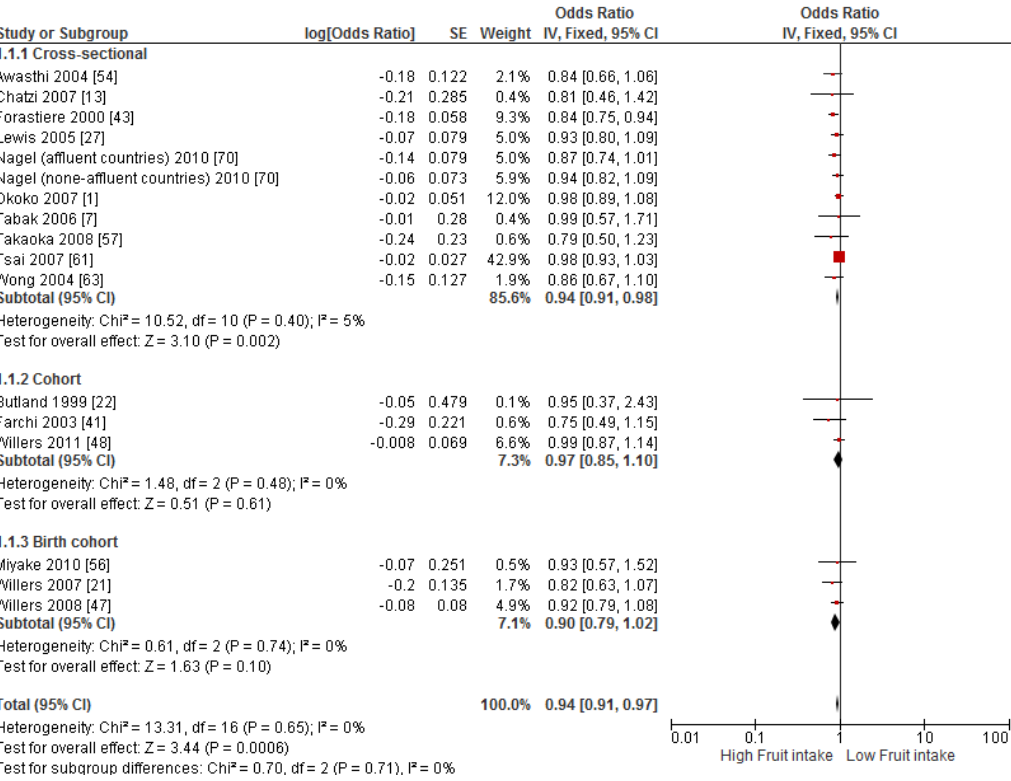
Figure 6. Meta ‐ analysis of the association between vegetable intake and severity of asthma.